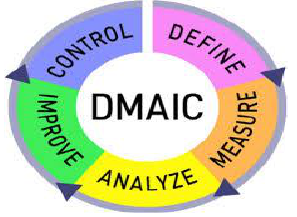
Fig. 14. Model for